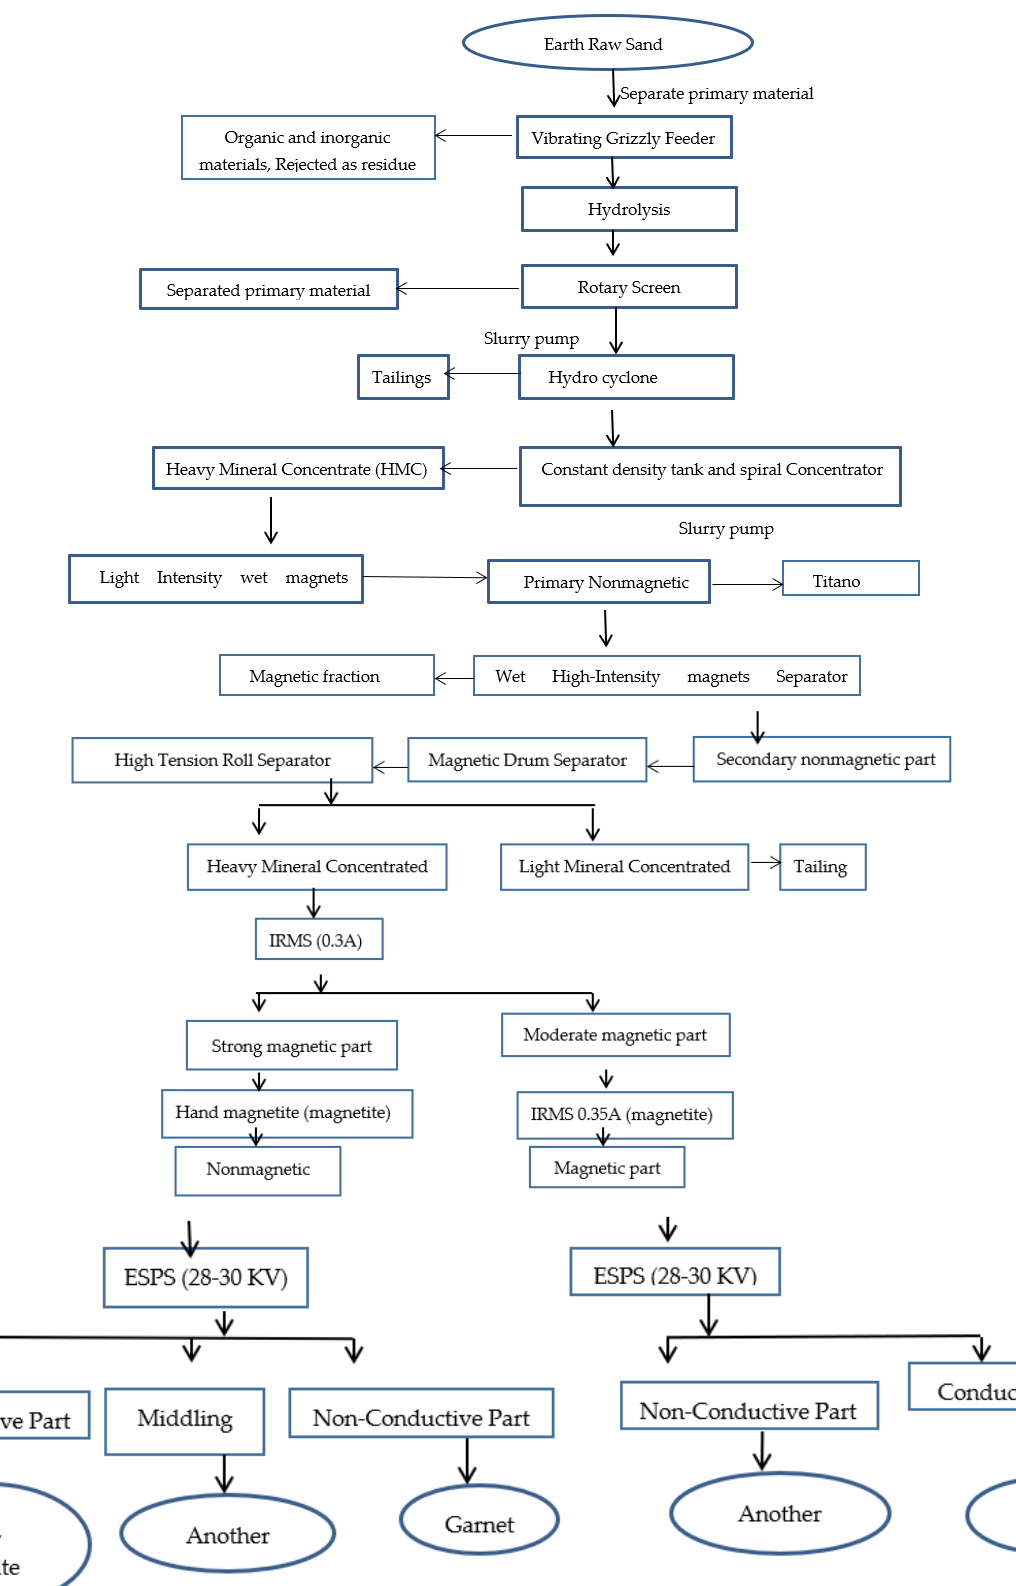
Figure 7. Flow chart of a pilot plant (wet and dry section) for the mineral Figure 7 . Flow chart of a pilot plant (wet and dry section) for the mineral separation .